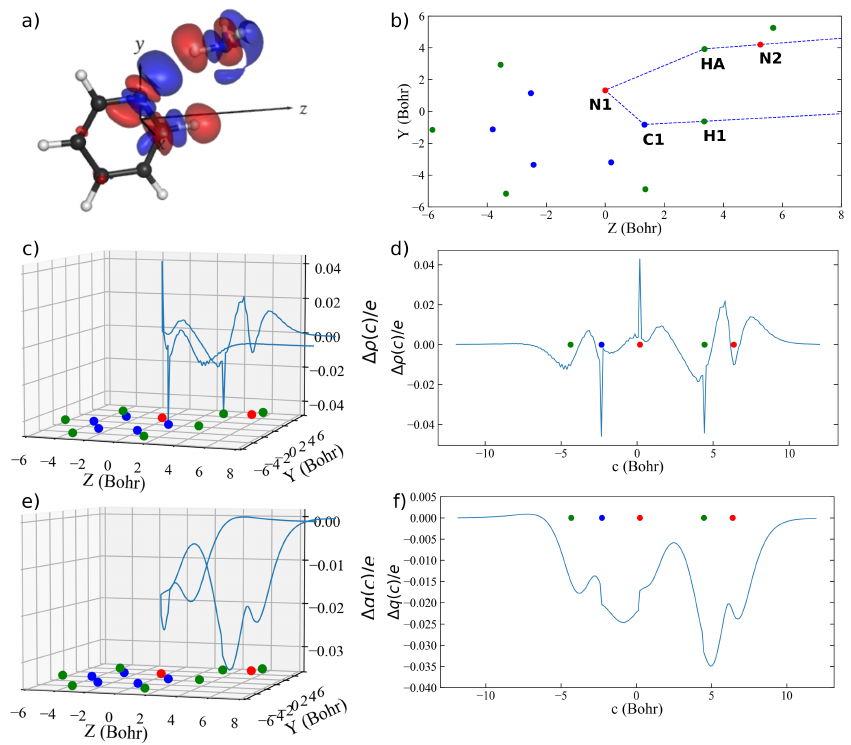
Figure 3. ( a ) ∆ ρ ( x , y , z ) for the pyridine–ammonia complex (isodensity surfaces at ± 0.0005 e/bohr 3 ; red lobes: electron depletion; blue lobes: electron accumulation). ( b ) Curvilinear path c lying in the pyridine molecular plane. ( c ) ∆ ρ ( z ) represented on the pyridine molecular plane. ( d ) ∆ ρ ( z ) linearized as a function of the curvilinear coordinate c . ( e ) ∆ q ( z ) represented on the pyridine molecular plane. ( f ) ∆ q ( z ) linearized as a function of the curvilinear coordinate c . The position of the hydrogen, carbon, and nitrogen atoms are indicated with green, blue, and red dots on the molecular plane,